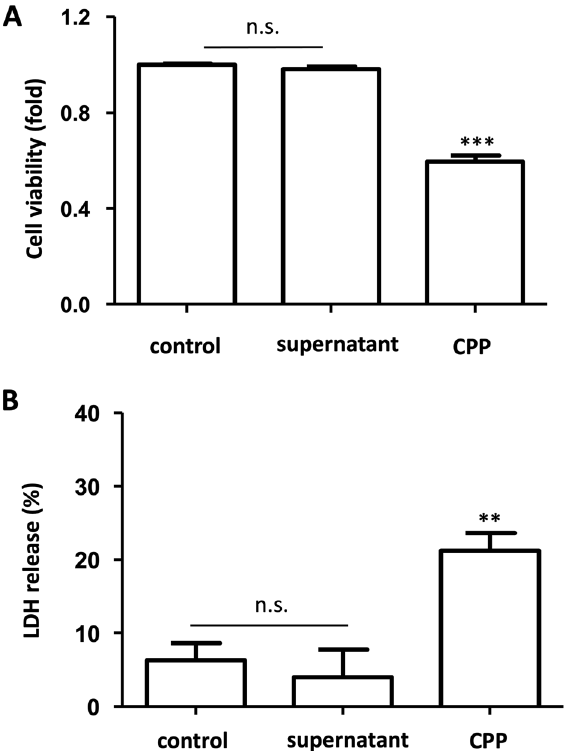
Figure 5. Effects of CPPs on DolKT-1 cell damage. Cell viability of DolKT-1 cells was measured by using a WST-1 method. Cells were treated for 24 h with the control medium, the supernatant of the high phosphate plus high calcium-containing medium after centrifugation, or CPP suspension ( A ). n = 6 for each group. LDH release was measured after treatment with control solution, supernatant, or CPPs for 24 h ( B ). n = 5 for each group. **P < 0.01, ***P < 0.001 vs. control. CPP calciprotein